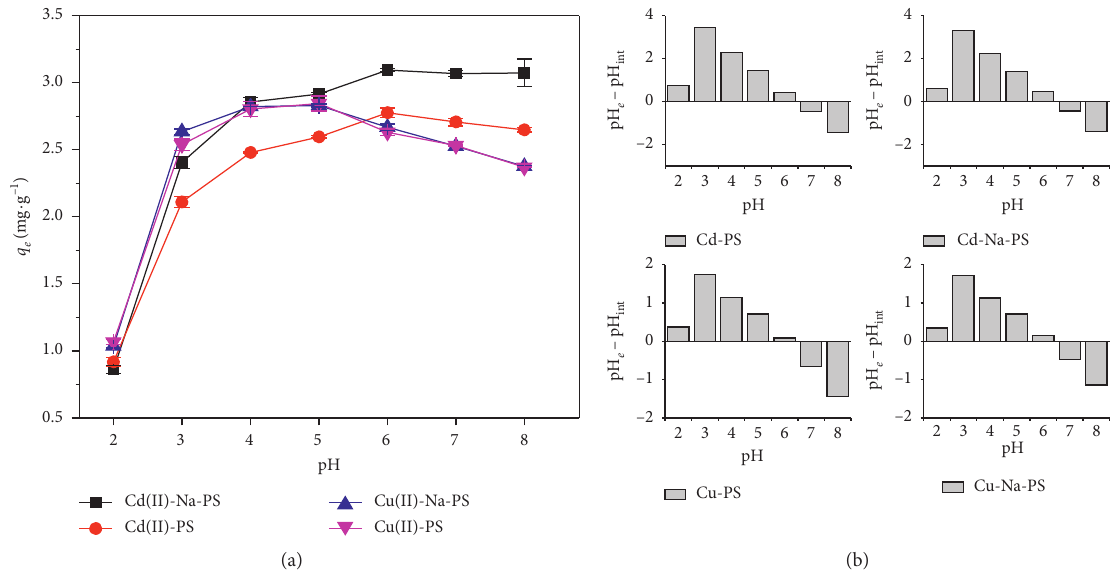
Figure 2: Effect of pH on Cd(II) and Cu(II) adsorption on PS and Na-PS. Note: PS means Pisha sandstone; Na-PS means modified Pisha sandstone by Na +